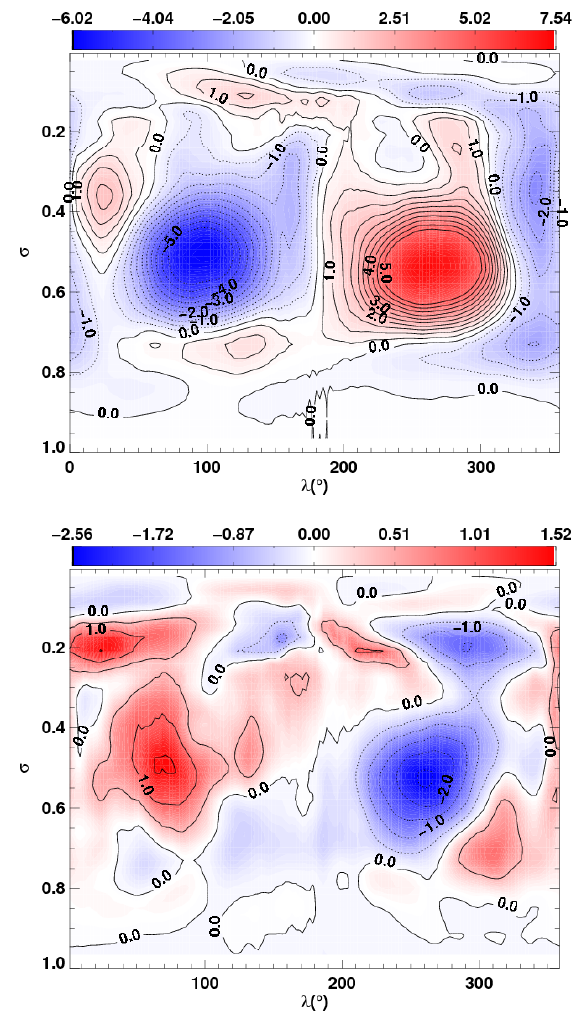
Figure 20. Figure showing, for the tidally locked Earth test (Merlis and Schneider, 2010; Heng et al., 2011b), the temporally and merid- Fig. 20. Figure showing, for the Tidally Locked Earth test (Merlis Fig. 20. Figure showing, for the Tidally Locked Earth test (Merlis ionally averaged meridional flow for the ND (top panel) and EG gc and Schneider, 2010; Heng et al., 2011b), the temporally and merid- and Schneider, 2010; Heng et al., 2011b), the temporally and merid- (bottom panel) models (see Table 2 for explanation of model ionally averaged meridional flow for the ND ( top panel ) and EG gc ionally averaged meridional flow for the ND ( top panel ) and EG gc ( bottom panel ) models (see Table 2 for explanation of model types). ( bottom panel ) models (see Table 2 for explanation of model types).